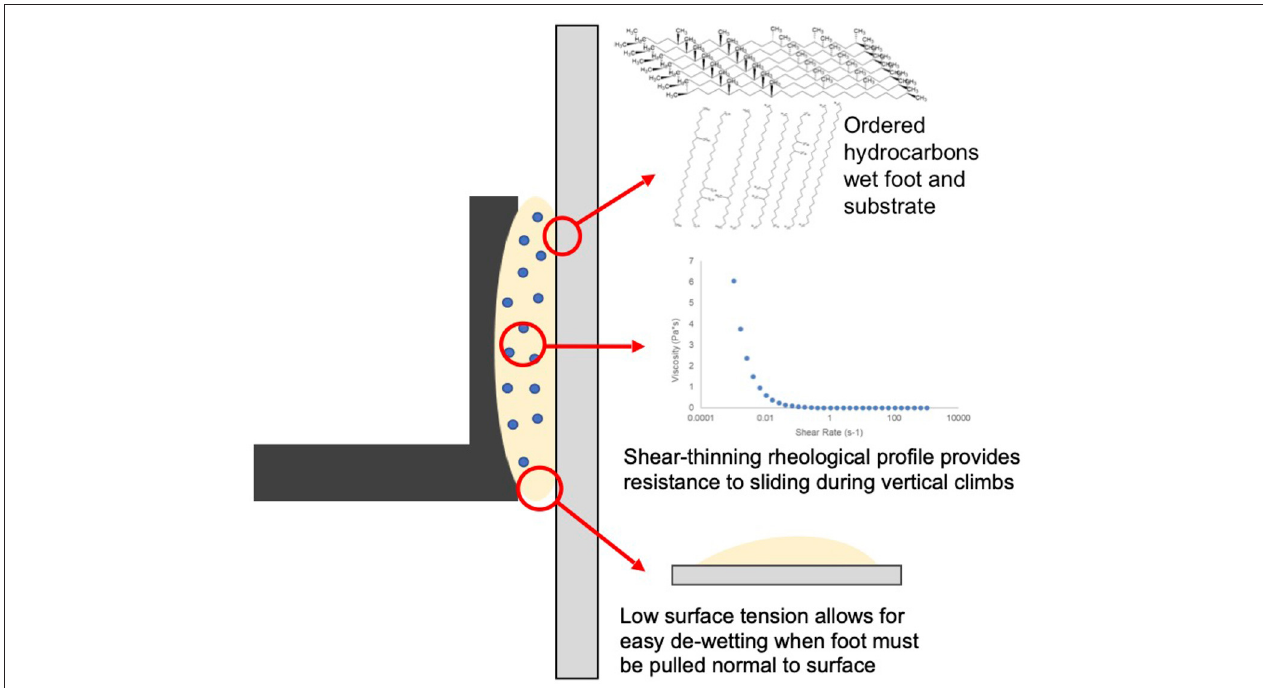
FIGURE 4 | The corresponding properties of natural and biomimetic insect tarsal adhesive fluid allowing fast attachment and detachment both essential for performing rapid